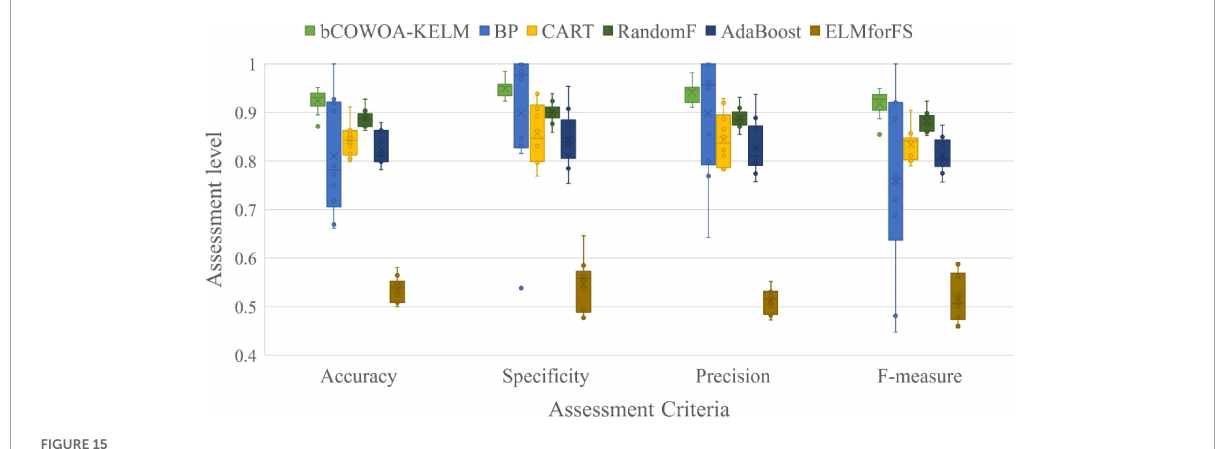
FIGURE15 Comparison results of the bCOWOA-KELM with five classifiers.